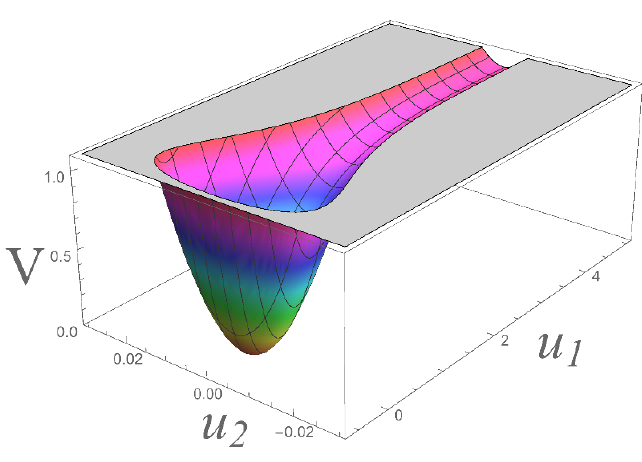
Figure 8 . Potential V ( u i ) in the theory de(cid:12)ned via equations (6.10) and (6.11). For M = 10 m we have a heavy and stabilized u 2 . The remaining (cid:12)eld u 1 plays the role of the in(cid:13)aton with the (cid:0)p (cid:0) 2 u 1 (cid:1) 2 corresponding to 3 (cid:11) = 1. The (cid:12)elds are shown E-model (cid:11) -attractor potential V = m 2 1 (cid:0) e in Planckian units M p = 1; the height of the potential is shown in units of m 2